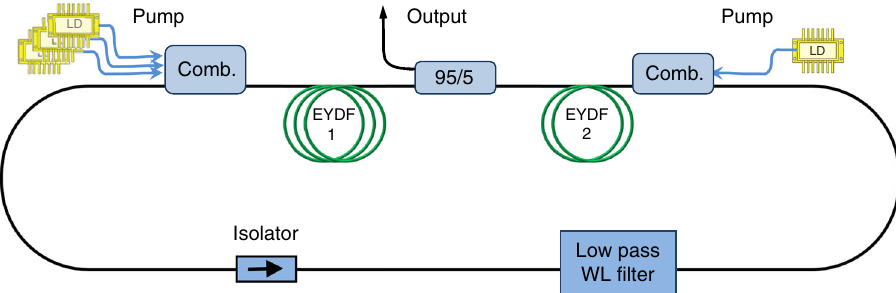
Fig. 1 Schematic of the basic fi ber cavity system. The cavity contains two gain sections of double-clad Er/Yb co-doped fi ber 1 (EYDF1) and EYDF2 with lengths of 9 and 1 m, respectively, two sets of laser diodes (LDs) pumping the EYDF through combiners from two sides to make the pump more uniform, a low-pass wavelength (WL) fi lter with a cutoff at λ 0 = 1568 nm, and an